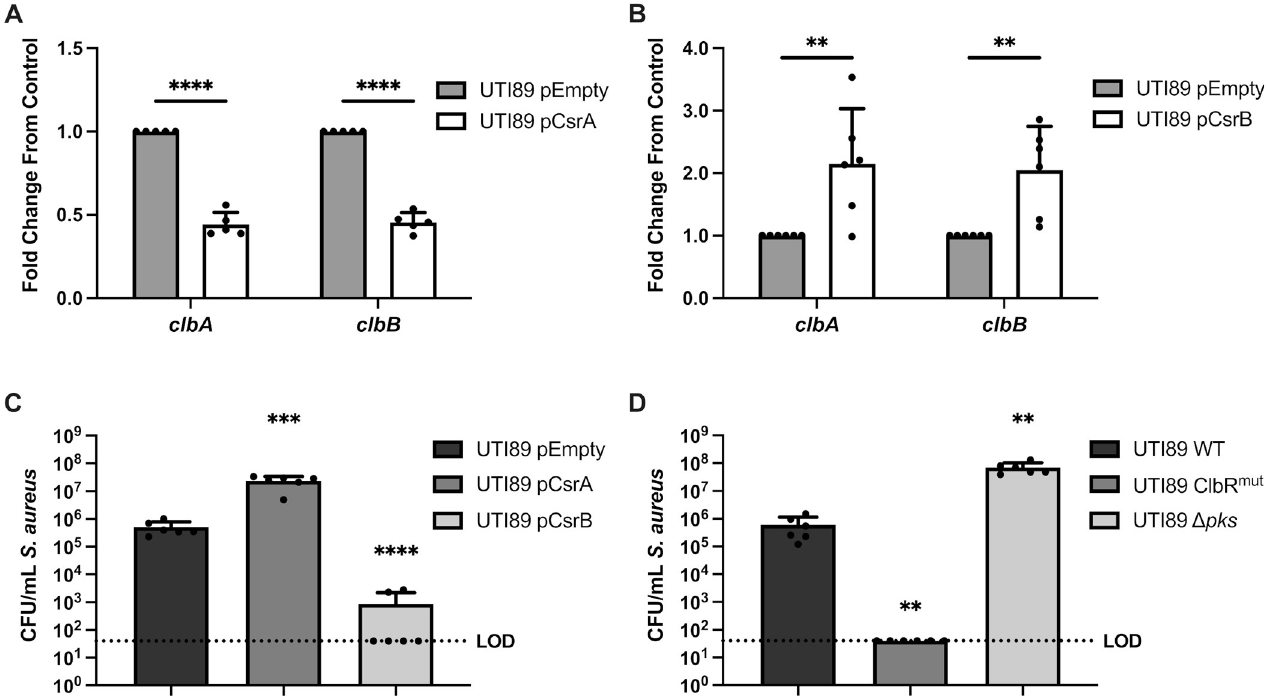
Fig 5. The BarA-UvrY TCS regulates the pks island via the Csr system. (A) RT-qPCR of 16 h macrocolonies of E . coli pTrc99a (pEmpty) and E . coli pTrc99a- CsrA (pCsrA). (B) RT-qPCR of 16 h macrocolonies of E . coli pEmpty and E . coli pCsrB. N = 5–6 independent experiments, each the average of 2 technical replicates. Gene expression was normalized to the gyrA housekeeping gene. Statistical significance was determined by two-way ANOVA with Bonferroni’s test for multiple comparison, �� p < 0.01, ��� < p < 0.001, ���� p < 0.0001, error bars represent SD from the mean. (C) Enumeration of S . aureus from 16 h mixed macrocolonies (1 EC :1 SA ) with either E . coli pEmpty, E . coli pCsrA or E . coli pCsrB. N = 6 independent experiments. ( D ) Enumeration of S . aureus mixed macrocolonies (1 EC :1 SA ) from 16 h with either E . coli WT, E . coli ClbR mut or E . coli pks deletion mutant. N = 6 independent experiments. Individual data points are indicated with closed circles. ( C and D ) Statistical significance was determined by Ordinary One-way ANOVA with Dunnett’s test for multiple comparison. ���� p < 0.0001, error bars represent SD from the mean. Statistical tests were performed on log-transformed data.